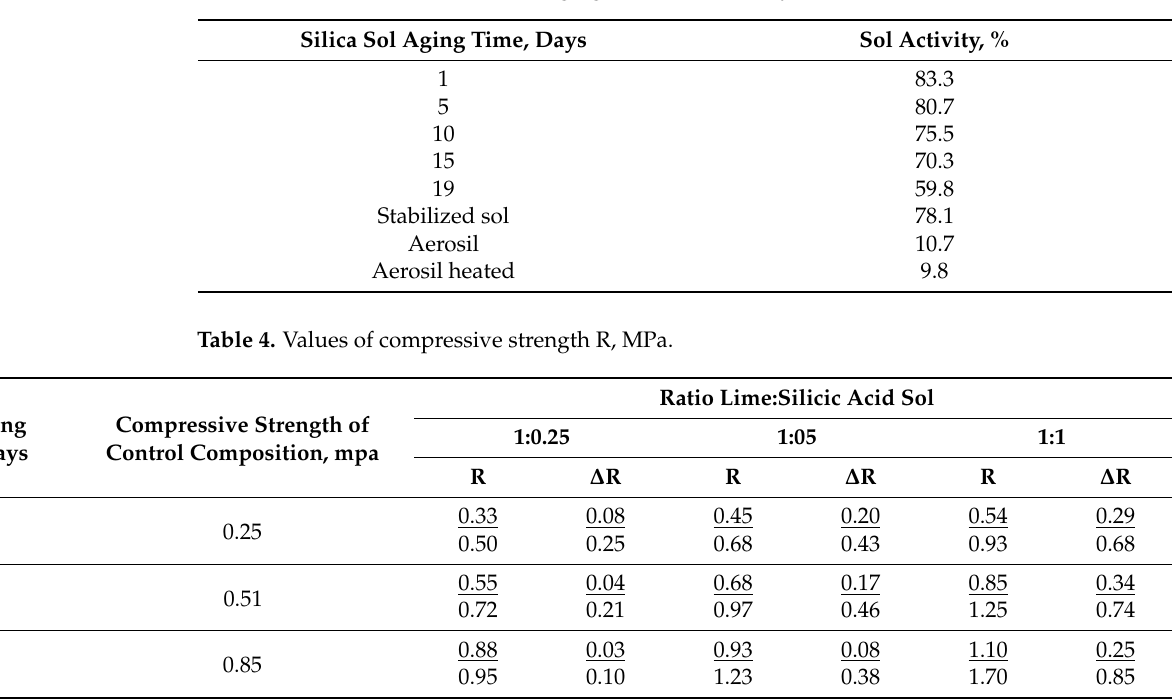
Table 3. Influence of silicic acid sol aging time on its activity.